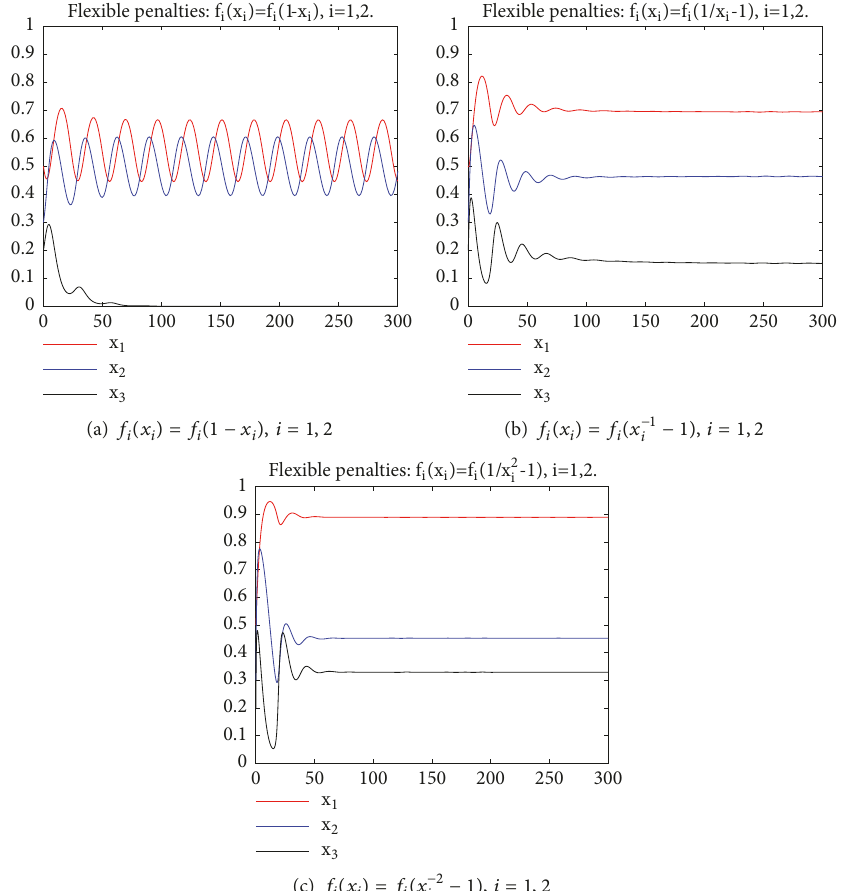
Figure 8: Time series graph of dynamical system under flexible penalty mechanism. Initial value is 𝑃 0 (0.5,0.3,0.2)